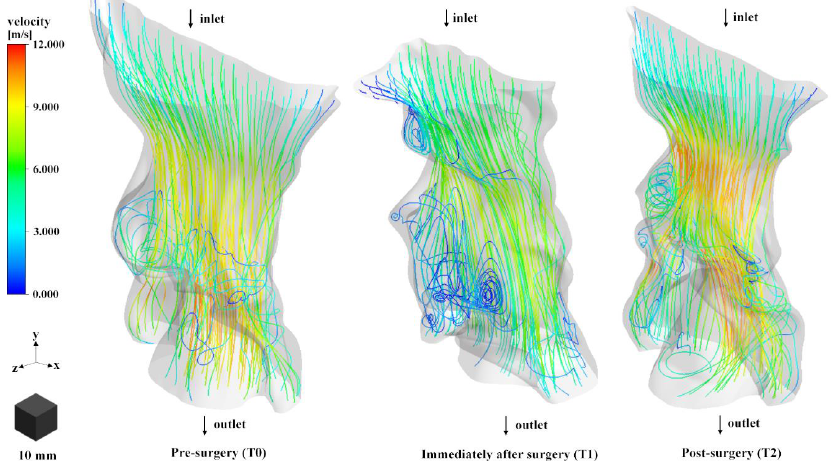
Figure 2. 3D streamlines in the 3D reconstructed model for pre-surgery, immediately after surgery, and post-surgery.